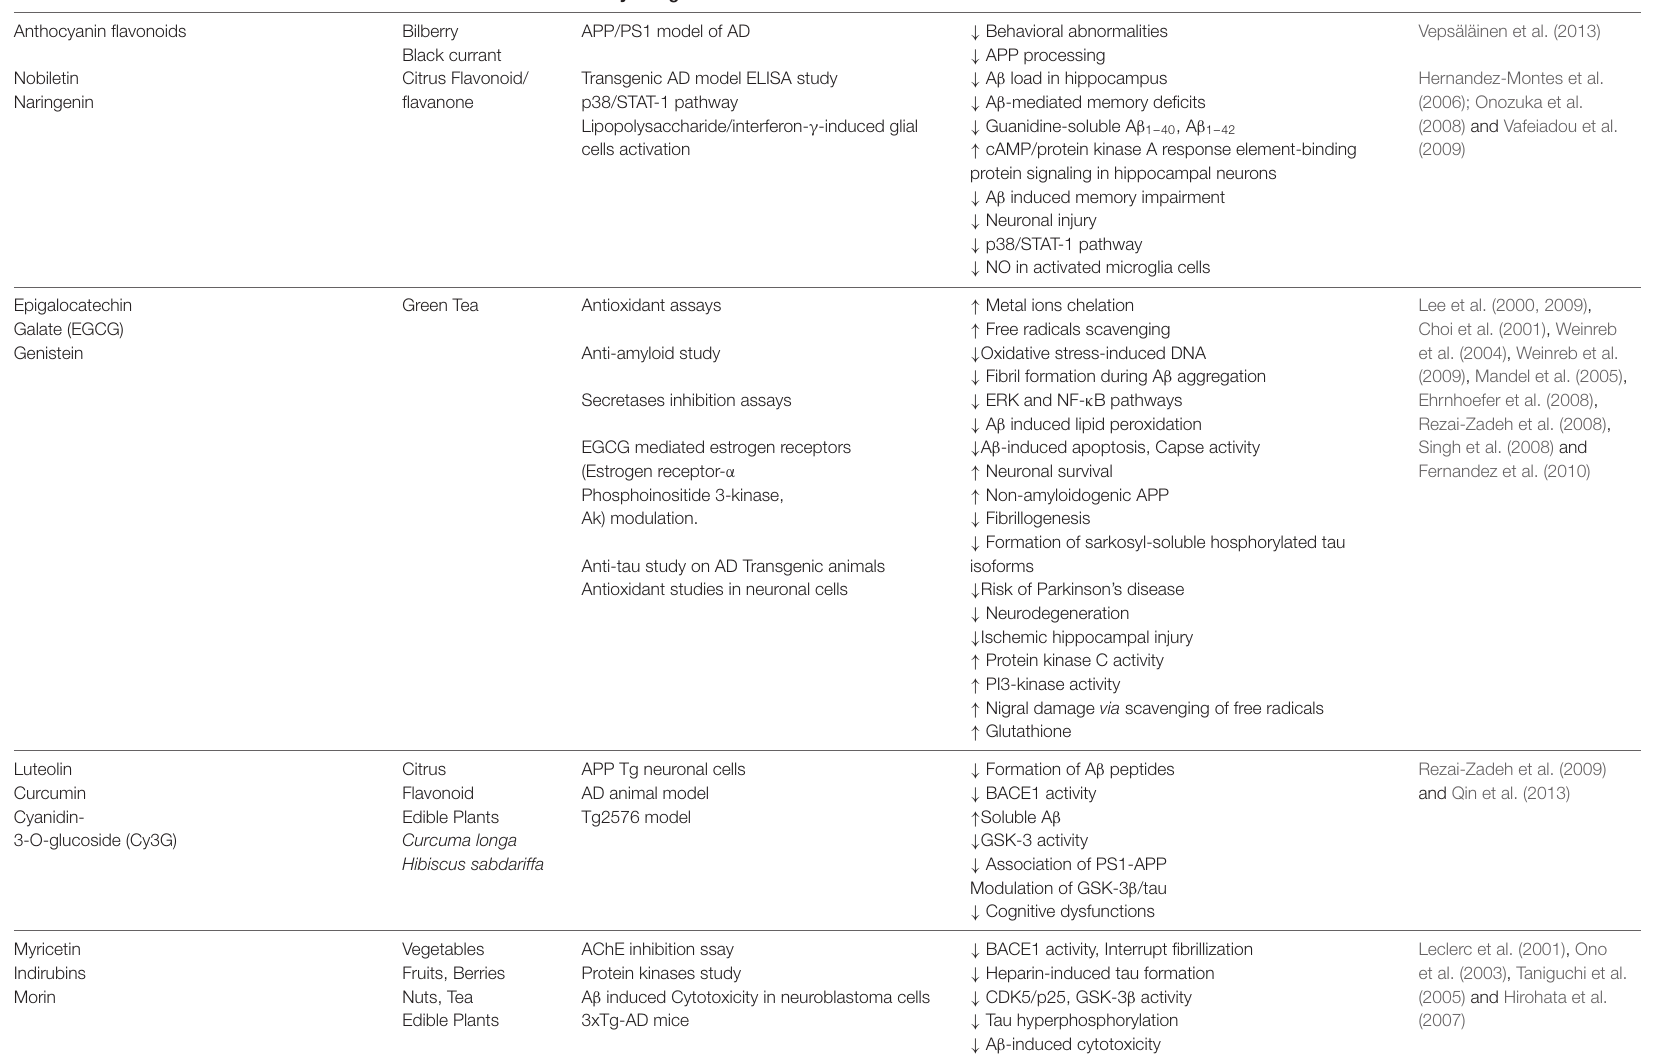
TABLE 1 | Summary of the prospective neuropharmacological activities of essential oils and bioactive compounds isolated from medicinal plants.